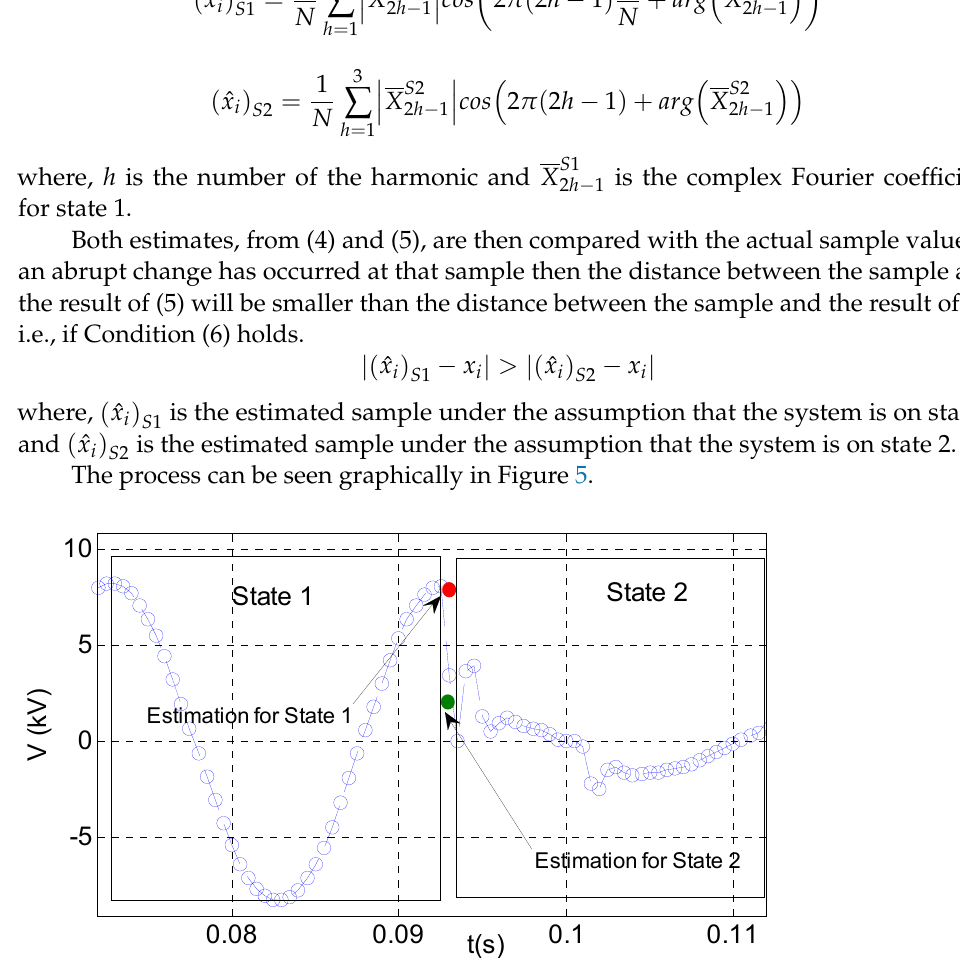
Figure 5. Example of the algorithm for determining abrupt changes in the waveform. There are two estimates for the suspected sample at which the abrupt change could have occurred (sample i ): one comprising the previous cycle’s sampling set; the second comprising the next cycle sampling set. If the distance between the observed sample i and the estimate of sample i using the state 2’s sampling set (next cycle’s samples) is smaller than the distance between the observed sample i and the estimate of sample i using state 1’s sampling set (previous cycle samples), then an abrupt change has occurred.